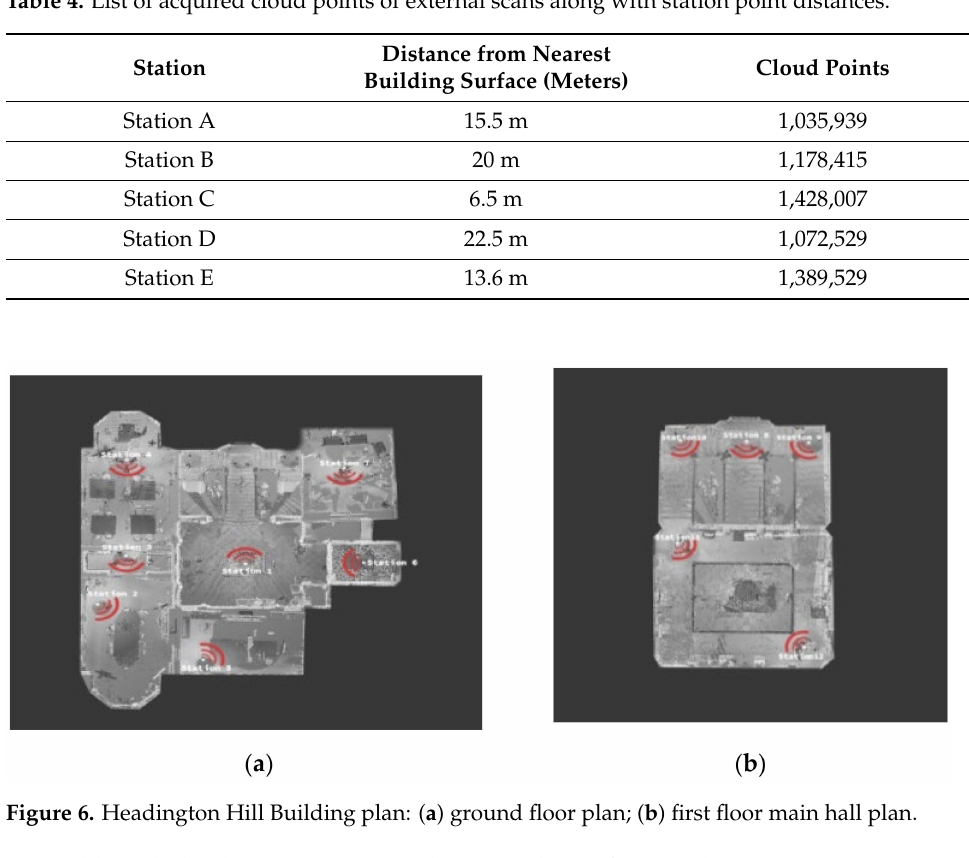
Figure 5. External scanning point placement on the Headington Hill Building site. Table 4. List of acquired cloud points of external scans along with station point